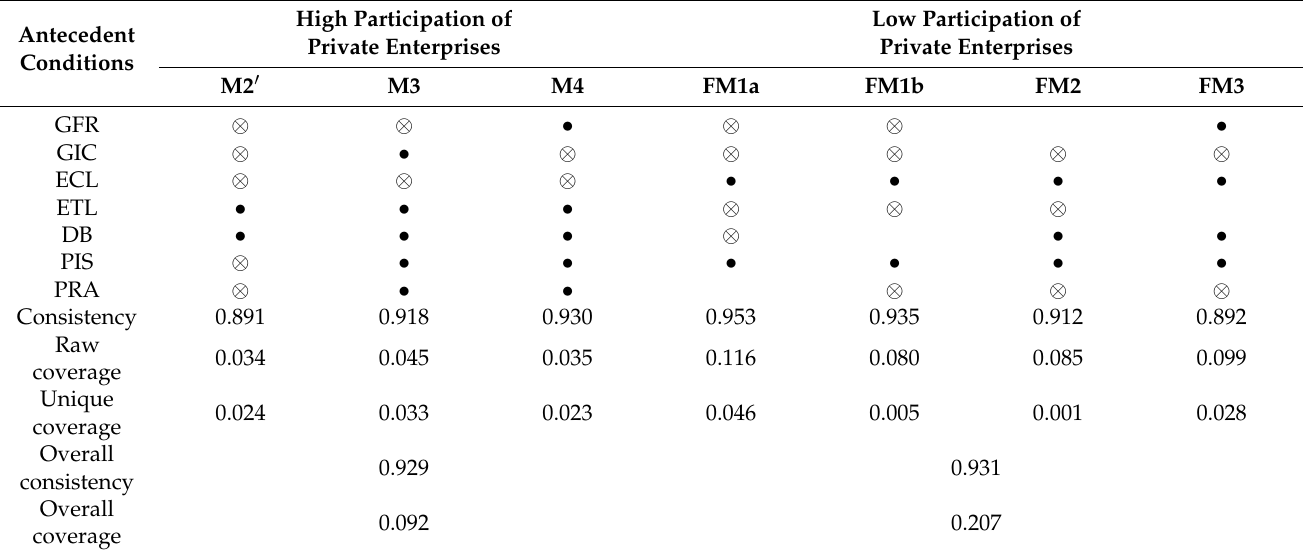
Table 5. Robustness tests for adjusting the consistency